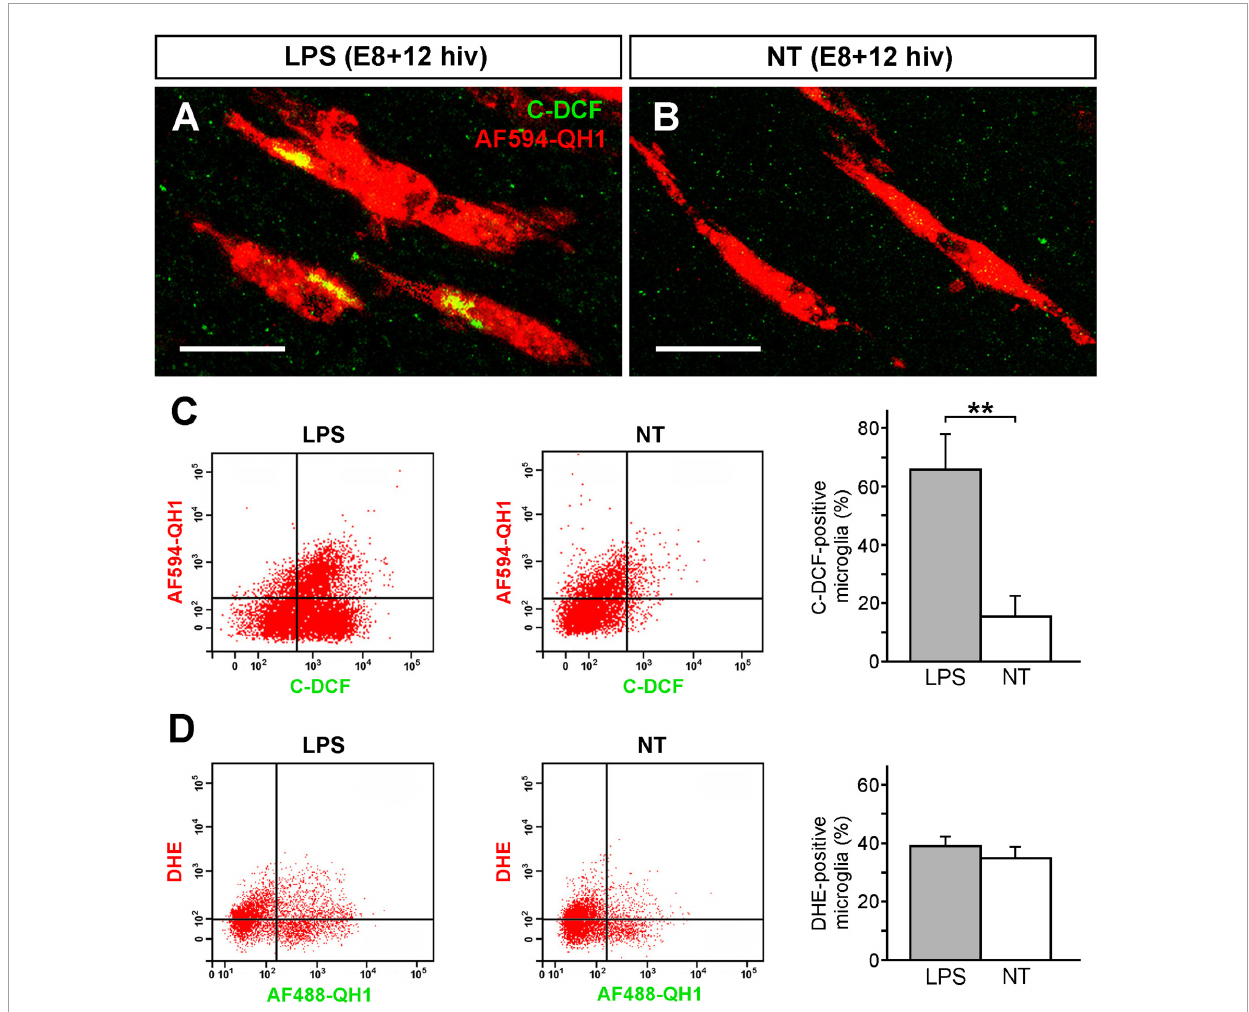
FIGURE5 Increase of microglial reactive oxygen/nitrogen species (RONS) after LPS treatment. Microglial cells increase production of RONS but not superoxide (O 2 - ) anions after LPS treatment of retina explants from E8 quail embryos cultured for 12 h in vitro (E8 + 12 hiv). (A,B) Representative confocal images of microglial cells from LPS-treated [LPS; (A) ] and non-treated [NT; (B) ] whole-mounted E8 + 12 hiv retina explants that were incubated for the last hiv in medium containing carboxy-H 2 DCFDA, which is converted to the fluorescent form carboxy-DCF (C-DCF, green) in the presence of RONS, and Alexa Fluor-594-conjugated QH1 antibody (AF594-QH1, red) as microglial marker. Images are maximum-intensity projections from Z stacks of confocal optical sections throughout the thickness of the ganglion cell layer (GCL). Scale bars: 20 µ m. (C) Representative dot plots of flow cytometry analysis to study ROS production by microglial cells in LPS-treated (LPS, left) and non-treated (NT, right) E8 + 12 hiv retina explants. Carboxy-H 2 DCFDA and AF594-QH1 were added to the explant incubation medium for the last hiv. RONS-producing microglial cells (QH1- and C-DCF-positive cells) in the upper right quadrant of each dot plot are more abundant in LPS-treated versus non-treated explants. Bar diagram on the right displays the percentages (means ± SEM) of C-DCF-positive microglial cells from the whole population of microglia obtained in flow cytometry analysis of LPS-treated (grey bar) and non-treated (white bar) explants ( n = 12 for each condition). The percentage of RONS-producing microglia is significantly higher in LPS-treated than in non-treated explants (** P < 0.01, Student’s t-test). (D) Representative dot plots of flow cytometry analysis to study O 2 - anion production by microglial cells in LPS-treated (LPS, left) and non-treated (NT, right) E8 + 12 hiv retina explants after addition of dihydroethidium (DHE) and Alexa Fluor-488-conjugated QH1 antibody (AF488-QH1) to the incubation medium for the last hiv. Percentages (means ± SEM) of microglial cells producing O 2 - anions (QH1- and DHE-positive cells) from the whole microglial population are shown in the bar diagram on the right. No significant differences (Student’s t-test) are found between LPS-treated (grey bar) and non-treated (white bar) explants ( n = 6 for each condition), showing that O 2 - anion production by microglia is not increased after LPS treatment of explants.